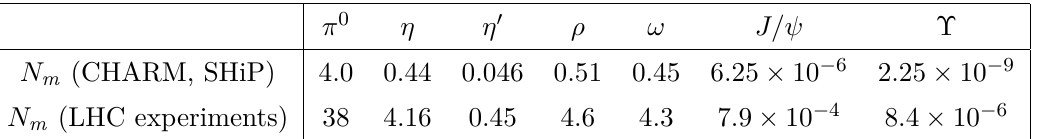
Table 1 . Average number of mesons produced per proton interaction for fixed target experiments (CHARM, SHiP) and for experiments at the LHC (FASER, MATHUSLA). See the text for details on how these multiplicities were